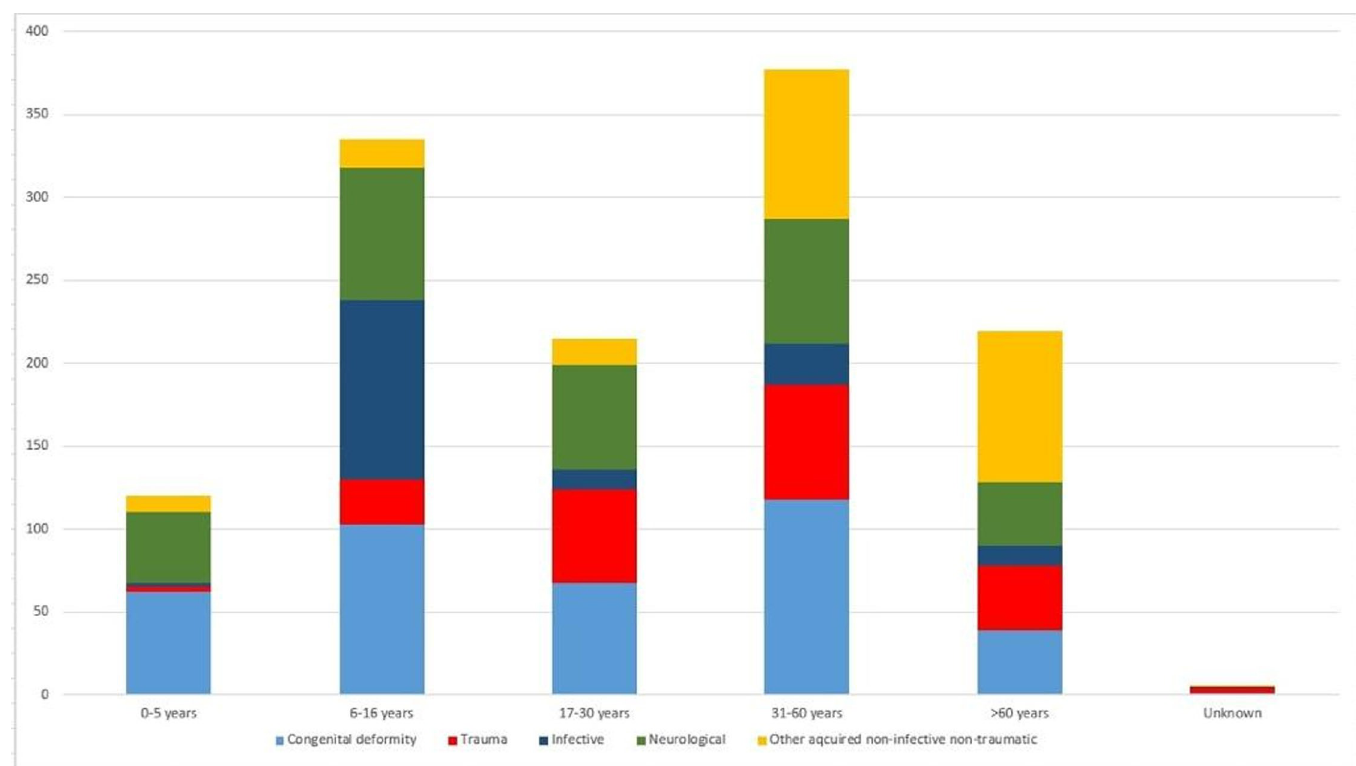
Fig 1. Number and diagnostic categories of MSI, by age group. Y-axis: Number of cases.